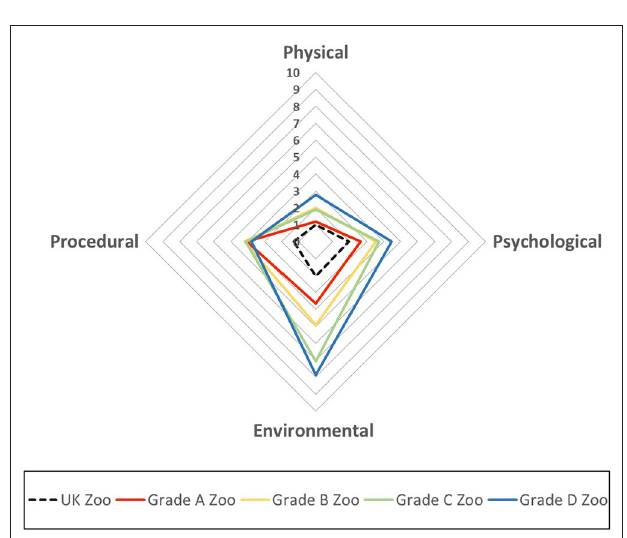
FIGURE 2 | The average modified Animal Welfare Assessment Grid (AWAG) in four sections for zoo grades A, B, C, and D (solid line) compared to UK zoos (dotted line). The South Korean AWAG scores in each section for the four zoo grades were larger than those for the UK